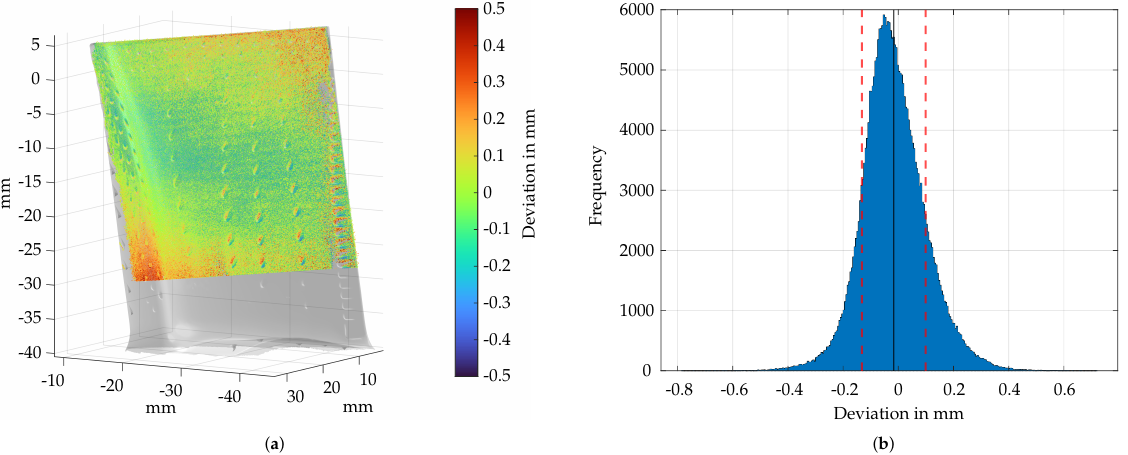
Figure 12. Deviation analysis of the endoscopic measurement compared to a reference measurement of turbine blade 5 using a GOM ATOS Core 200. ( a ) Point deviation of the endoscopic measurement compared to a reference measurement of turbine blade 5. ( b ) Histogram of the point deviation of ( a